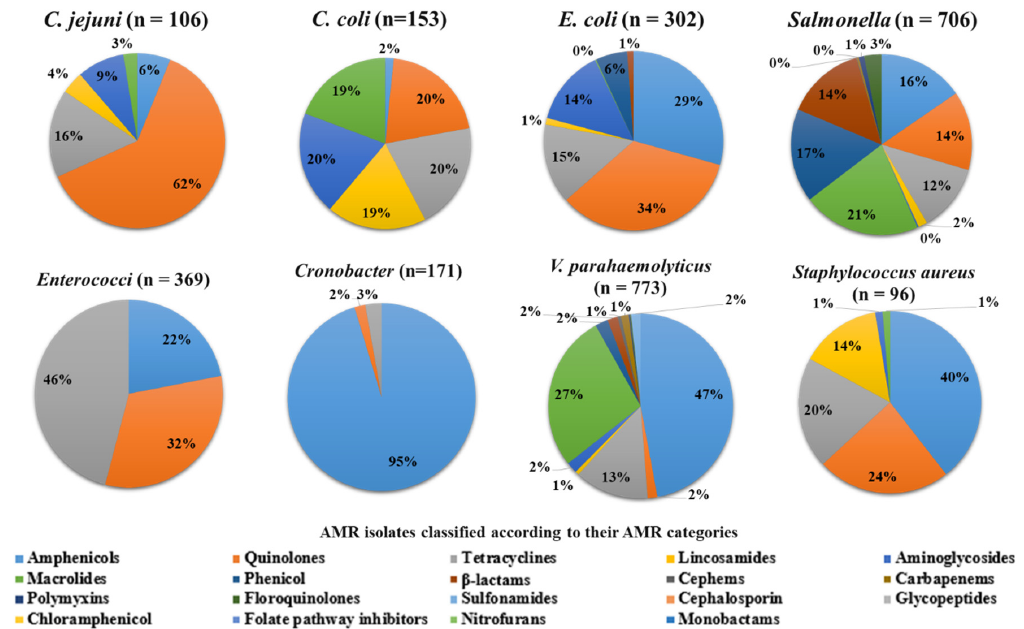
Figure 6. Based on the phenotypic AMR detected against the major AM classes in China, distributions of AMR isolates of foodborne pathogens and indicator bacteria have been determined (n = 2676) (n = total number of food samples contaminated with certain bacteria).